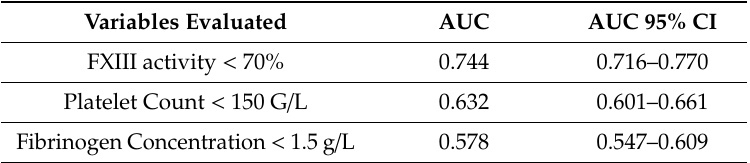
Table 4. Receiver operating characteristics (ROC) curves’ areas under the curve (AUC) of FXIII activity, platelet count, and fibrinogen for the prediction of red cell